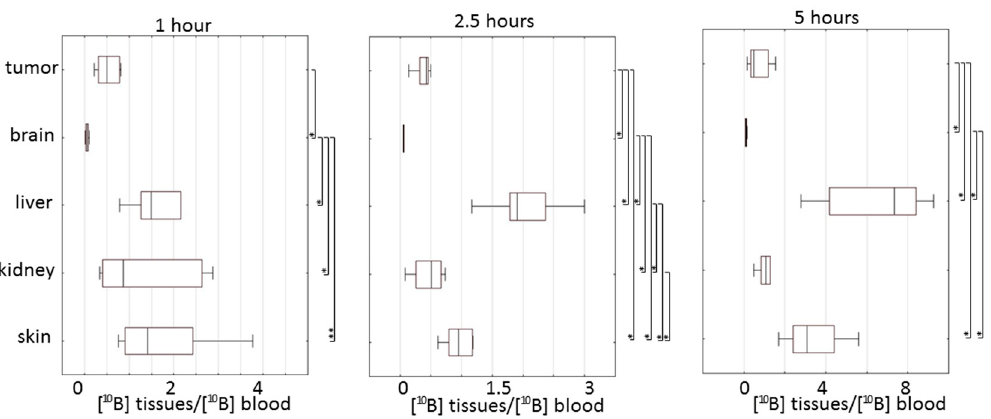
Figure 6. Box plots of [ 10 B] ratios between tissues and blood in different tissues at 1, 2.5 and 5 h after injection of BSH. Box borders indicate 25th and 75th percentiles; lines within boxes indicate the median. Significance of differences for 10 B uptake in tissue was defined by Mann–Whitney pairwise comparison and a subsequent Bonferroni post-test. * Statistical difference at p < 0.05. ** Statistical difference at p < 0.001.